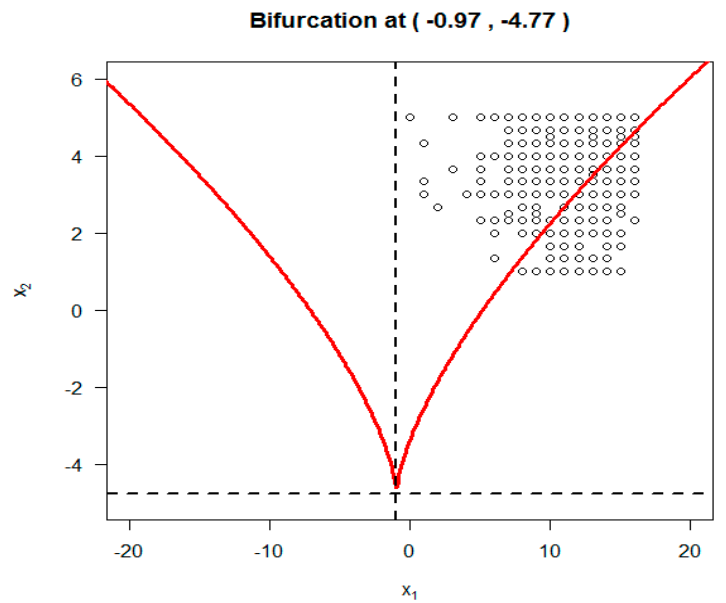
Figure 3. Estimated bifurcation point from the SDECusp modeling.